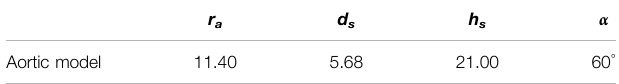
TABLE 1 | Aortic model structure size parameters (mm).